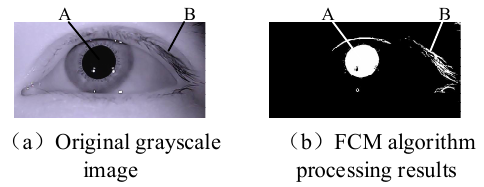
Figure 3. FCM segmentation results. ( a ) Original grayscale image ， point A is one pixel point in the pupil region, point B is another pixel point in the eyelashes region, and the two pixel points have very close gray values. Figure 3b is the segmentation result, and point A and point B are the same cluster. ( b ) FCM algorithm processing results.